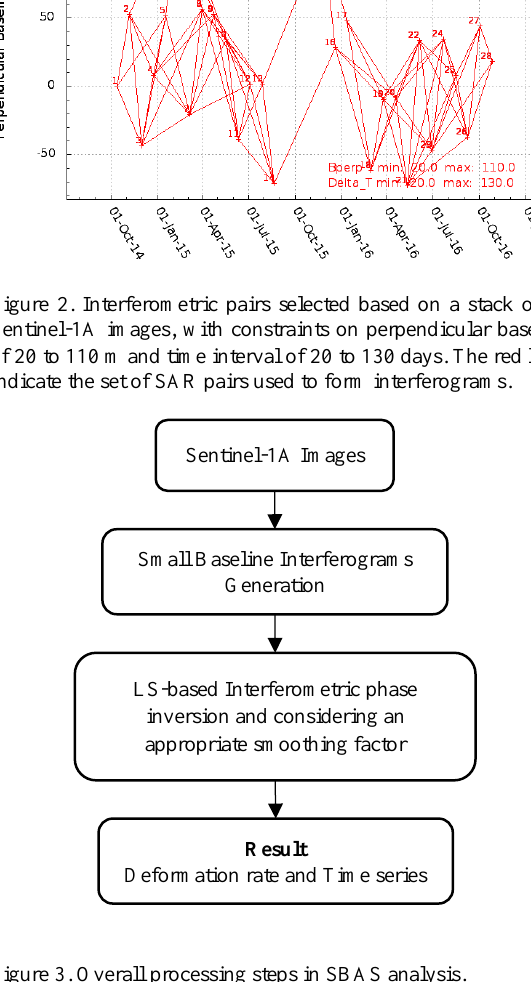
Figure 3. Overall processing steps in SBAS